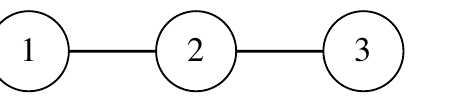
Figure 2. Message exchange network: Users 1 and 2, and users 2 and 3 are neighbors. User 1’s message is invisible to user 3, and vice